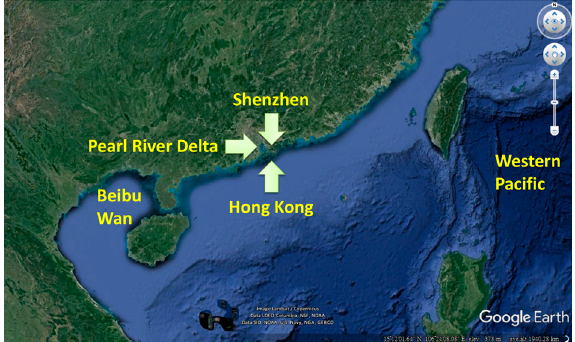
Figure 1. A map of Hong Kong and its vicinity.